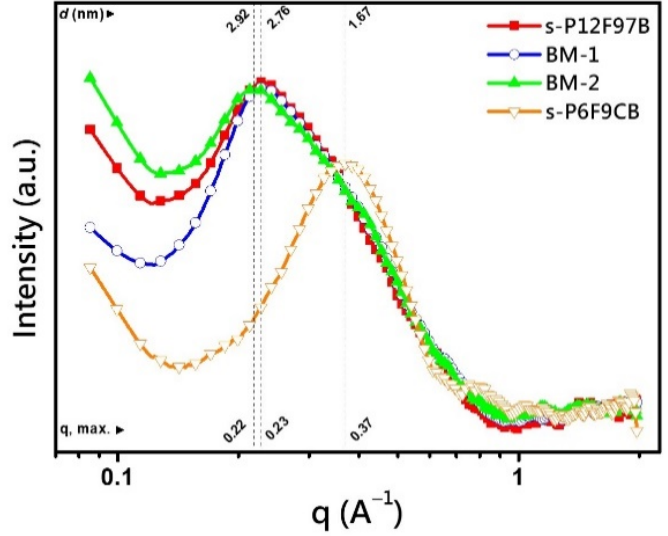
Figure 7. SAXS spectrum of the BM-X membranes.